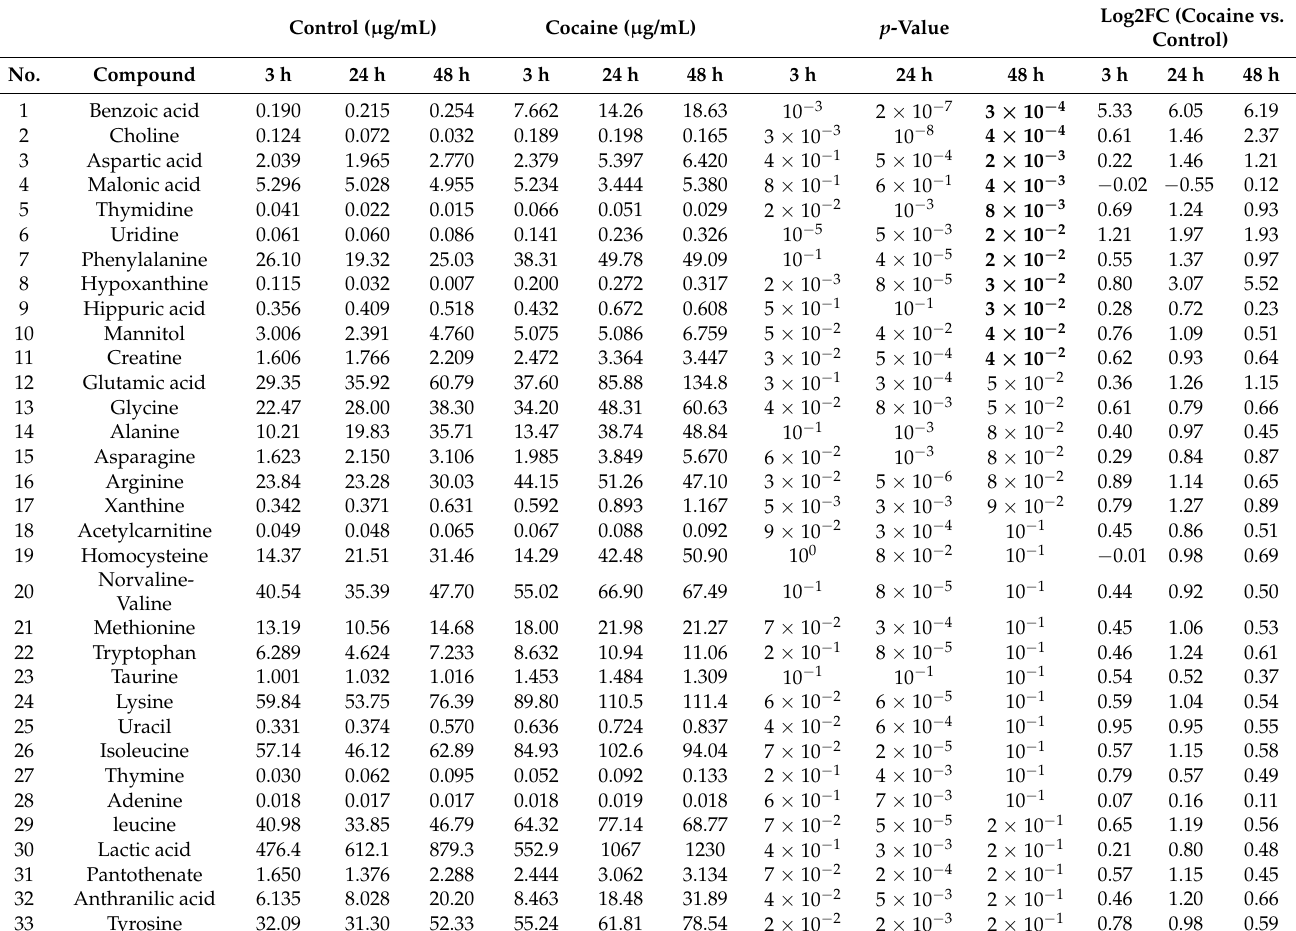
Table 2. Metabolites that were detected in cell medium and their p -value and fold change value at each time point; the compounds are listed based on their p -values at 48 h (cocaine vs. control), increasing from top to bottom.